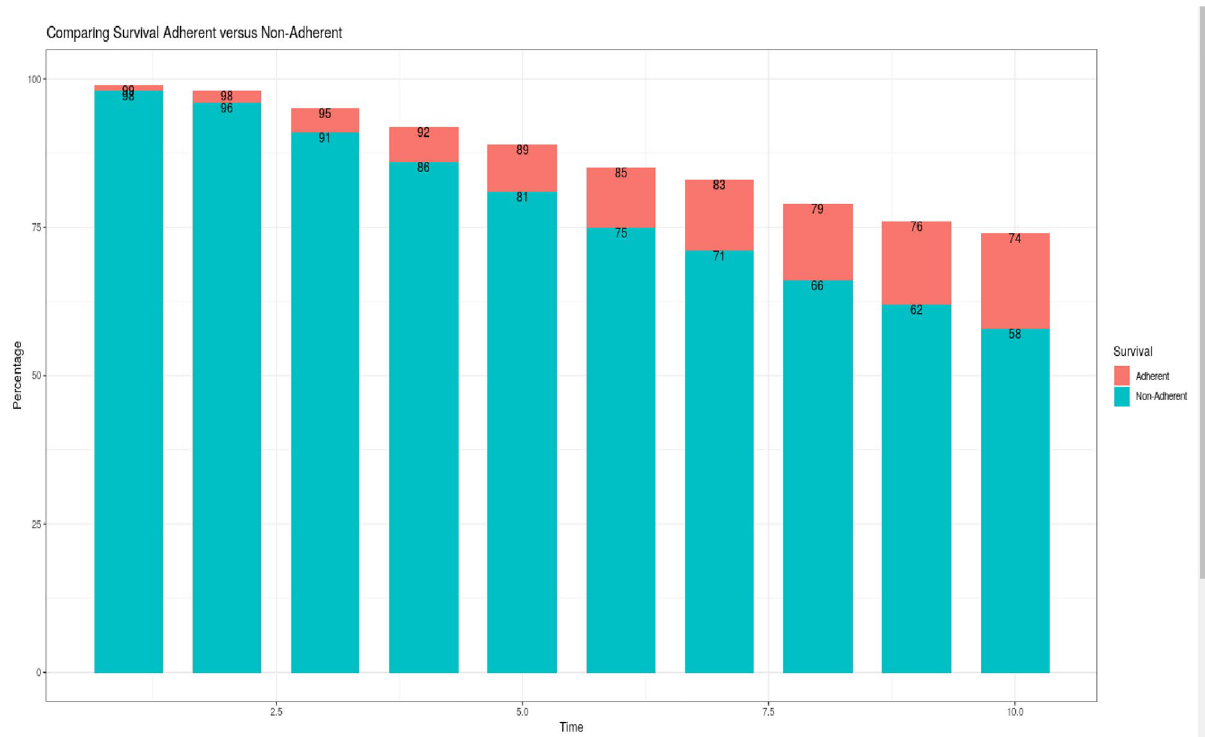
Figure 5. Snapshot of the web-based survival prediction application BreCanSurvPred. This snapshot shows the comparison of survival according to adherence to endocrine treatment for a 60-year old patient diagnosed with molecular subtype HER2 − /HR + in stage III. These survival probabilites are calculated up to 10 years after BC diagnosis. (Time: time since diagnosis [follow-up]; Percentage: percent survival at a certain Time